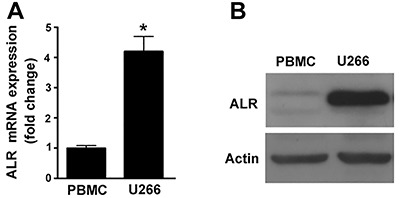
Augmenter of liver regeneration (ALR) expression was elevated in U266 MM cells. A, qRT-PCR, and B, western blot analysis of the mRNA and protein levels of ALR, respectively, in U266 multiple myeloma cells and healthy peripheral blood mononuclear cells (PBMCs). Representative blots from 3 independent experiments are shown in B. *P<0.05 vs PBMC; n=3 (Student t-test).